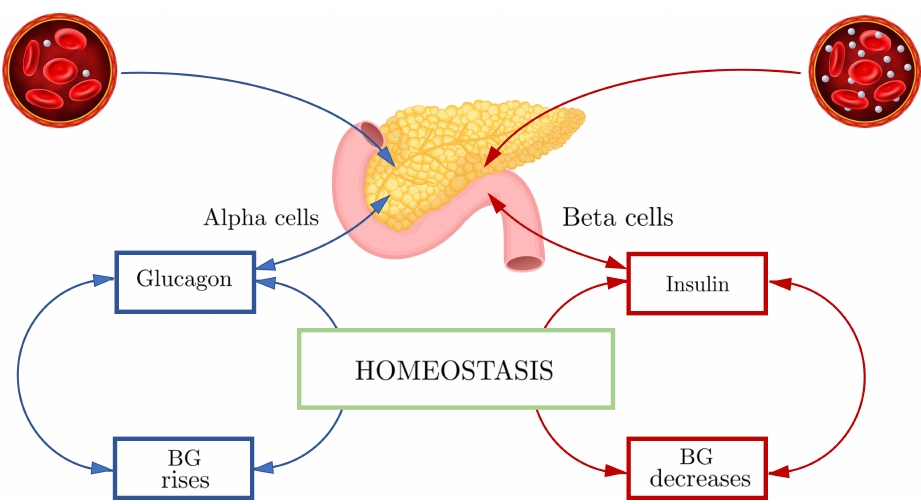
Figure 2. Blood glucose homeostasis